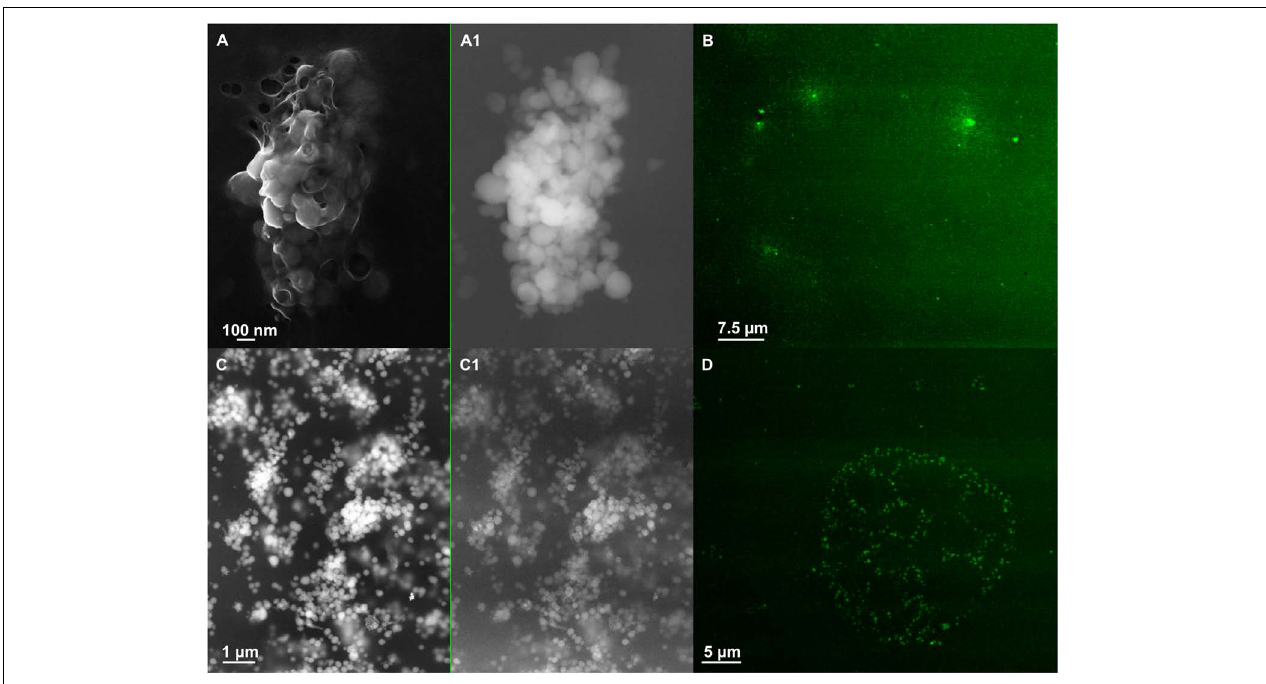
FIGURE 6 | Scanning electron microscopy (SEM) of SeNPs SeITE02 − G_e [ A (In Lens detector), A1 (detector for back scattered electron)] and SeNPs SeITE02 − P_e [ C (In Lens detector), C1 (detector for back scattered electron)]. Confocal laser scanning microscopy (CLSM) of SeNPs SeITE02 − G_e (B) and SeNPs SeITE02 − P_e (D) labeled with the lipophilic tracer DiOC 18